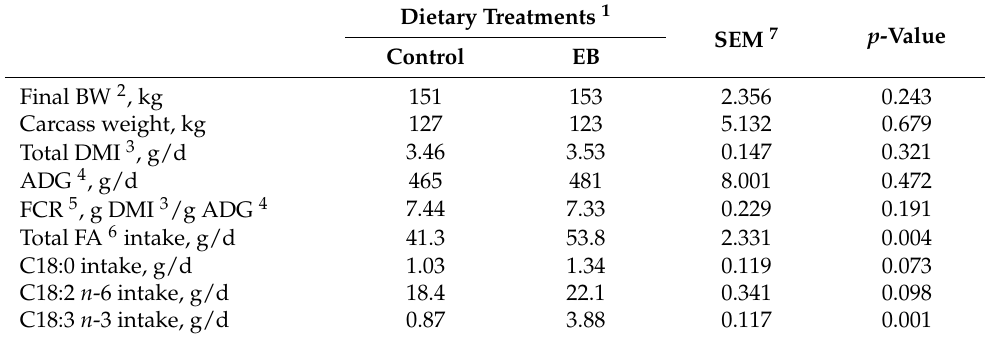
Table 2. Pigs’ performance in vivo and